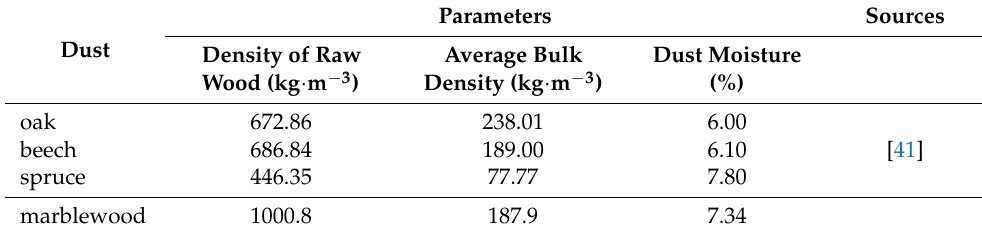
Table 1. Comparison of density and moisture of selected wood dusts with experimental sample.